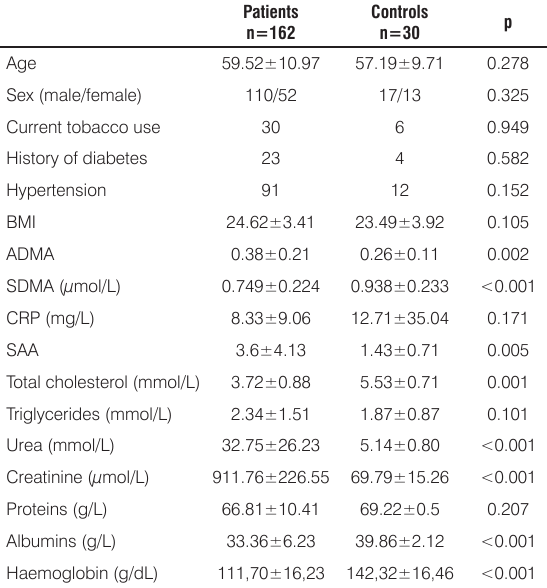
Table 1. Baseline characteristics for ESRD patients on hemodialysis and healthy